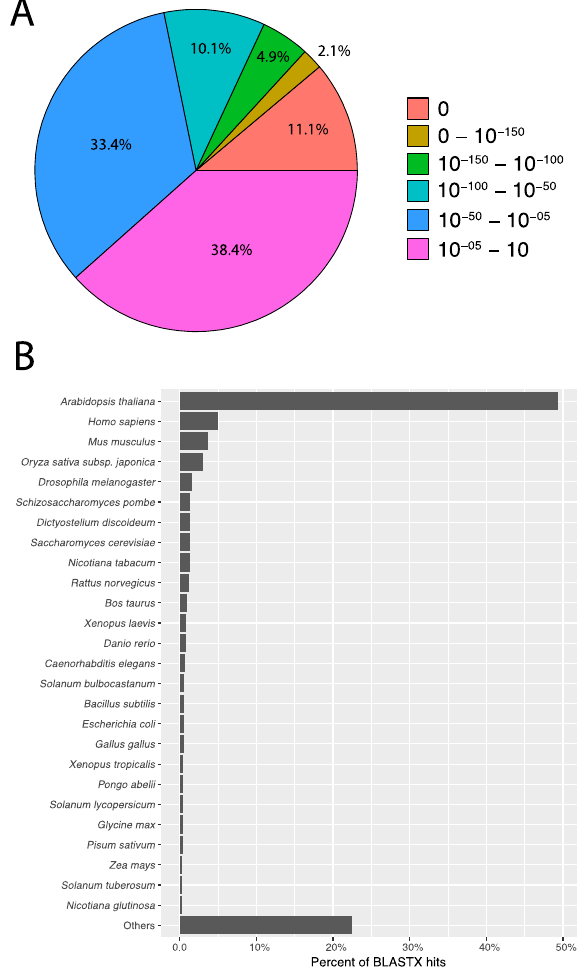
Figure 4. BLAST search results and species distribution. ( A ) E-value distribution for best BLASTX hit of transcripts against the SwissProt database. ( B ) Distribution of species for best BLASTX hit of transcripts against the SwissProt database.